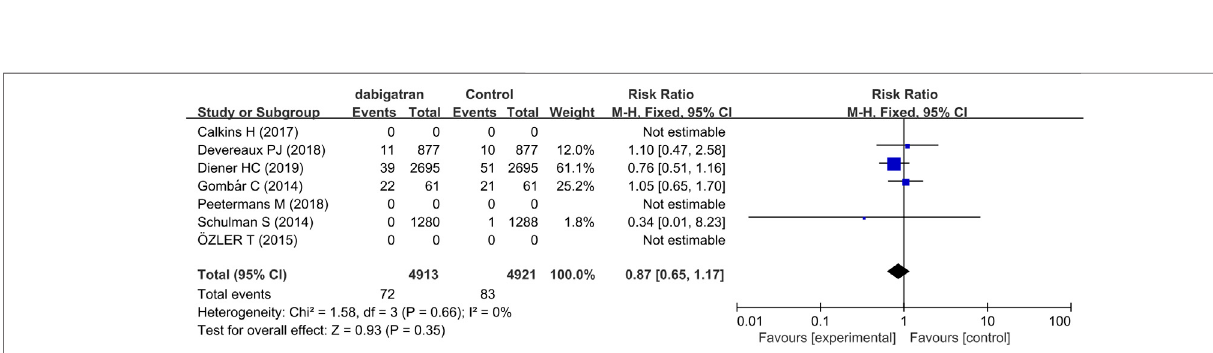
Frontiers in Pharmacology |